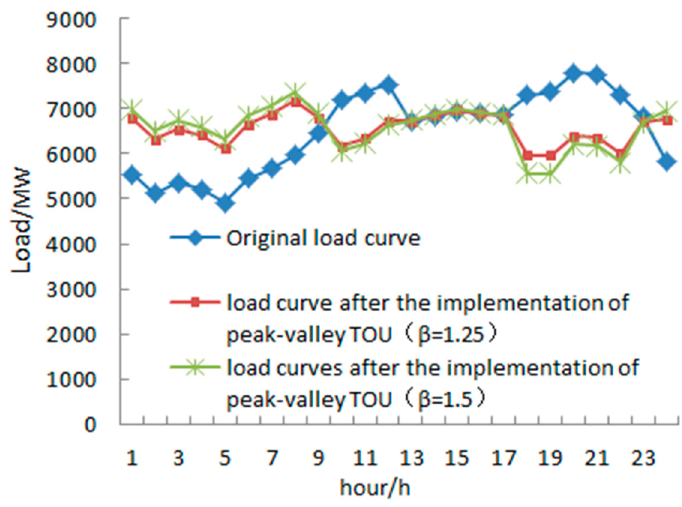
Figure 3. Load curve of a typical load day.